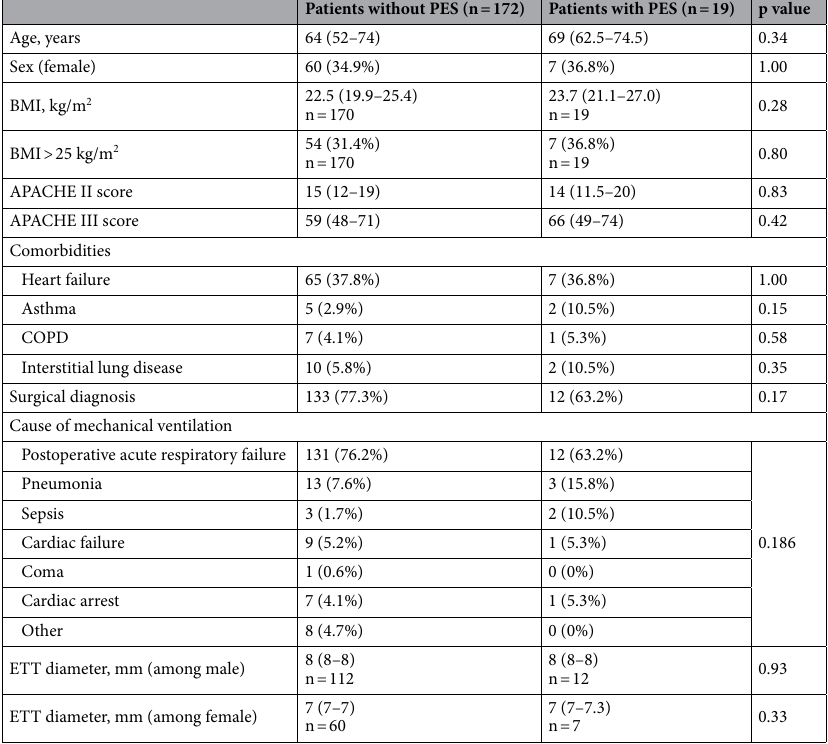
Table 3. Characteristics of patients with or without PES. Data are presented as median and interquartile range or number (percentage). PES post-extubation stridor, BMI body mass index, APACHE acute physiology, and chronic health evaluation, COPD chronic obstructive pulmonary disease, ETT endotracheal tube.